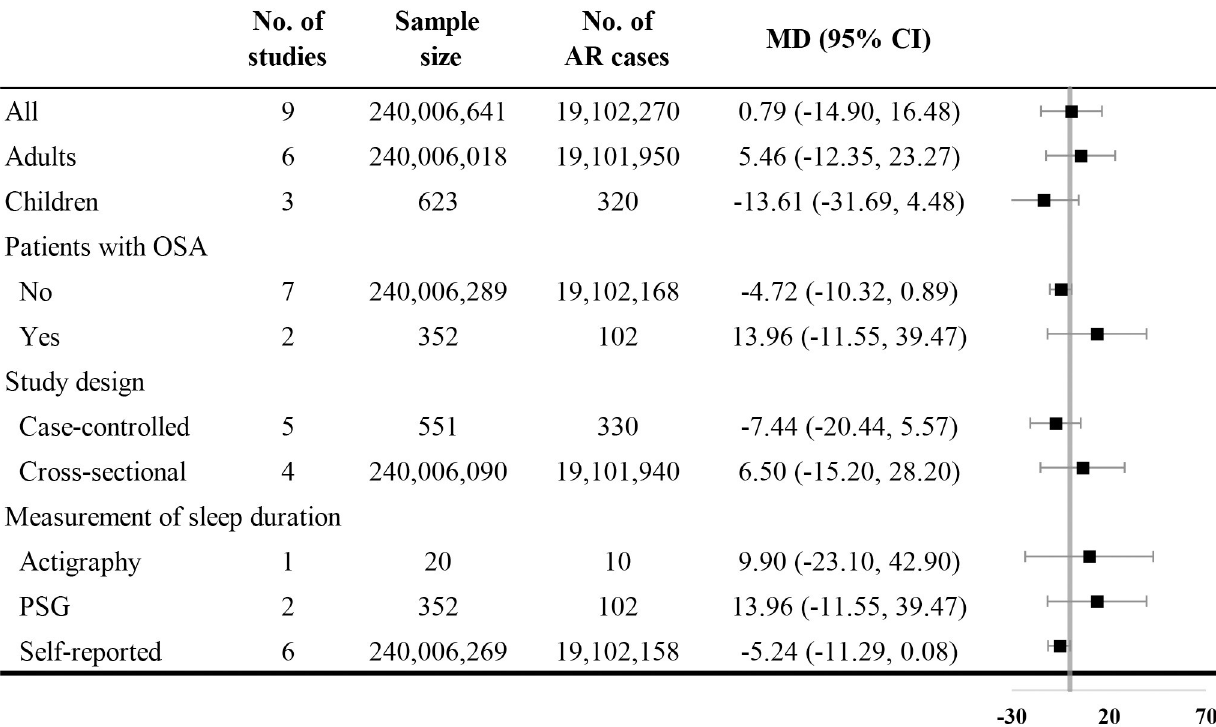
Fig 2. Comparative analysis of sleep duration. AR: allergic rhinitis; CI: confidence interval; MD: mean difference; OSA: obstructive sleep apnea; PSG: polysomnography.